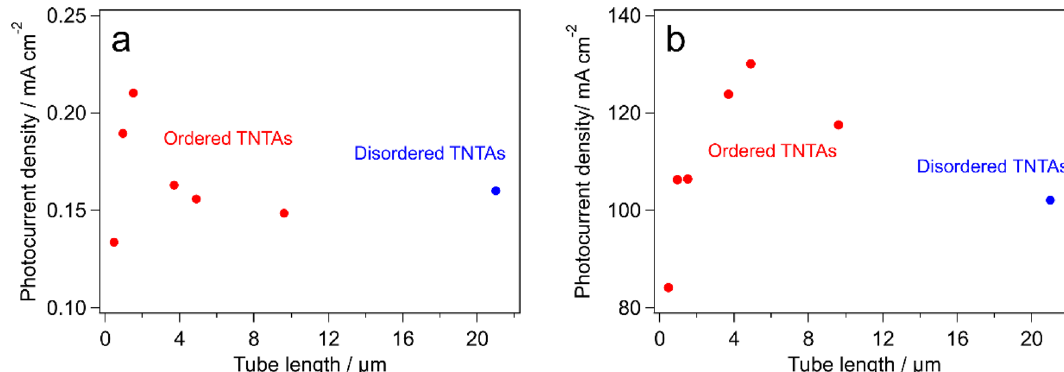
Figure 4. Photocurrent vs. TNTAs tube length under ( a ) simulated solar irradiation and ( b ) UV